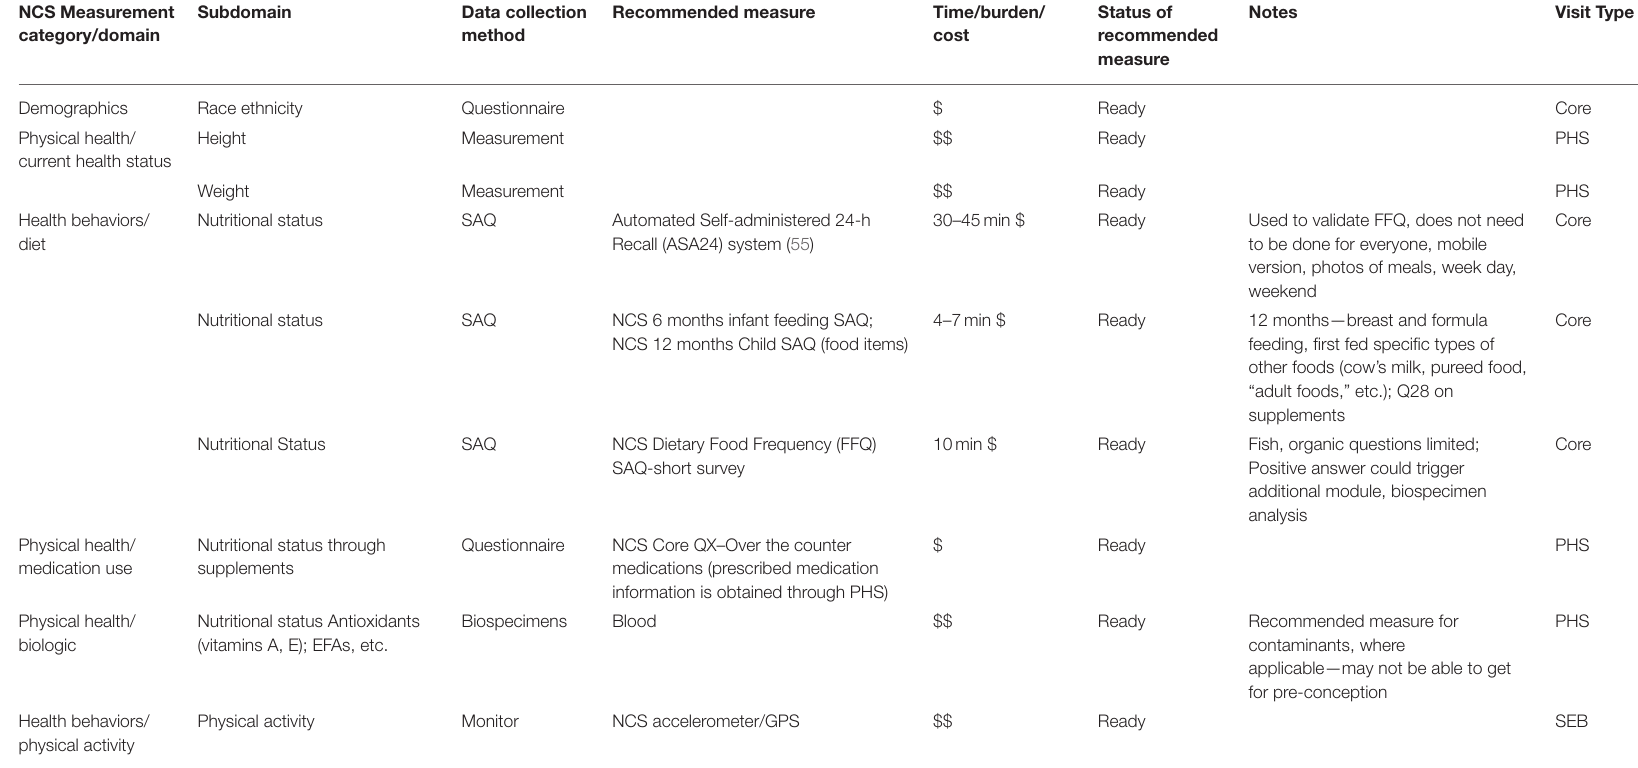
TABLE 5 | Domain: Modifying factors. NCS Measurement